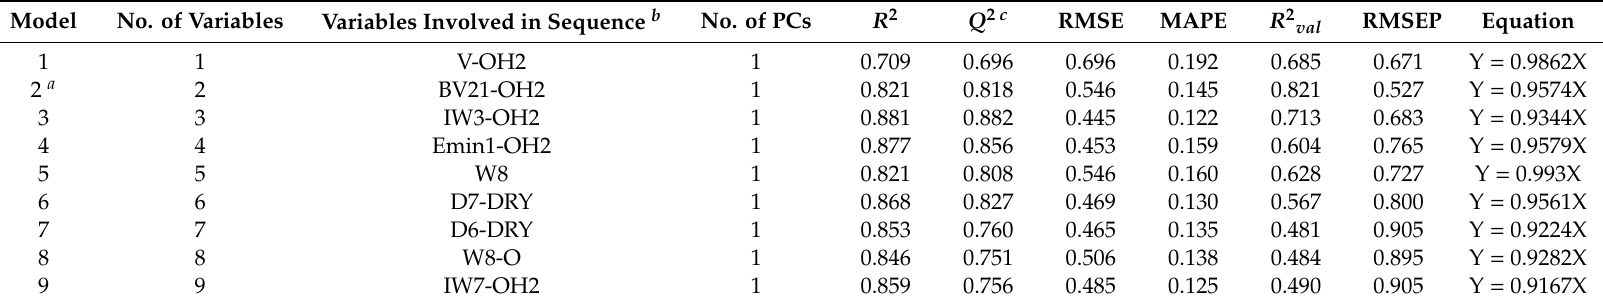
Table 4. PLS modeling results of the dissociation rate constants of p38 mitogen-activated protein kinase (p38 MAPK) inhibitors. Model